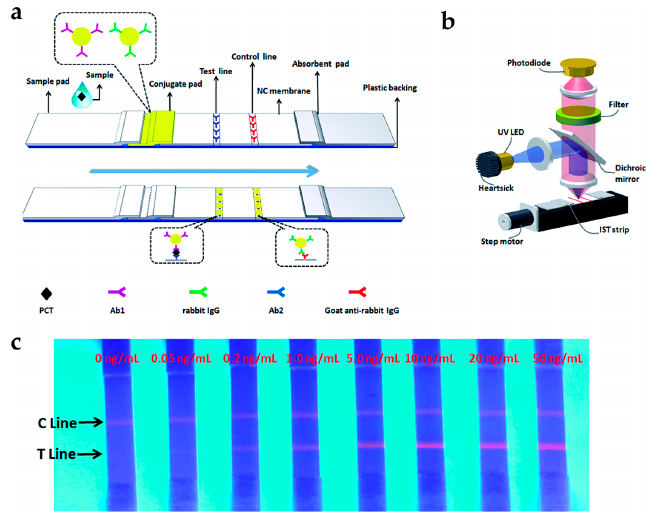
Figure 3. ( a ) Schematic representation of immunochromatographic strip tests (IST) for procalcitonin (PCT) detection; ( b ) Schematic of IST reader; ( c ) Quantitative analysis of the PCT levels using IST. Reprinted with permission from [27].